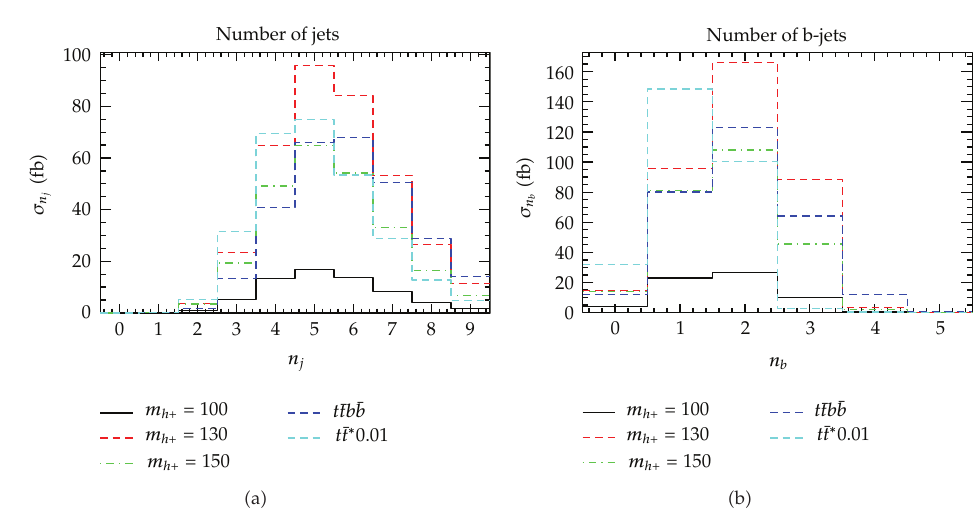
Figure 8: Jet (cid:2) a (cid:3) and b -jet (cid:2) b (cid:3) multiplicity for the signal and backgrounds when using the anti-kT algorithm with R (cid:7) 0 . 5. Table 2: Integrated signal cross-sections (cid:2) cf. Figure 9 (cid:3) for the three di ff erent charged Higgs masses as well as the two backgrounds. The integration region is 90 to